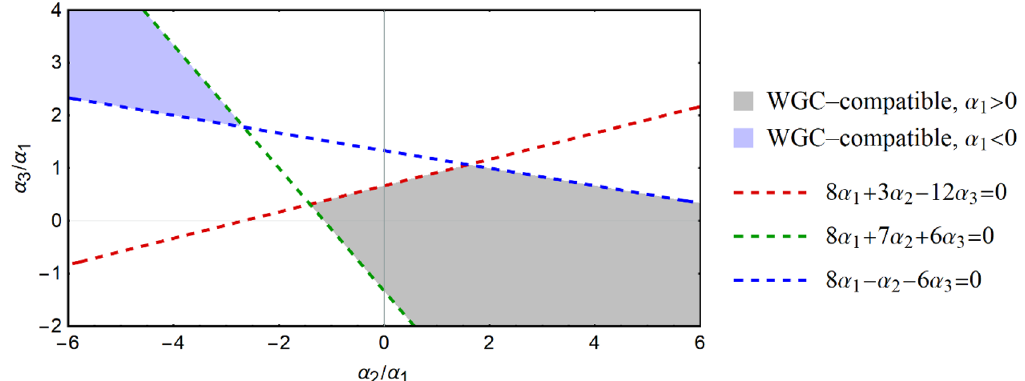
Figure 5 . Comparison of the complementary bounds in eq. (4.62). The dashed lines show equality and the gray and blue shaded regions show where all three in equalities are simultaneously satisfied with α 1 > 0 and α 1 < 0 ,